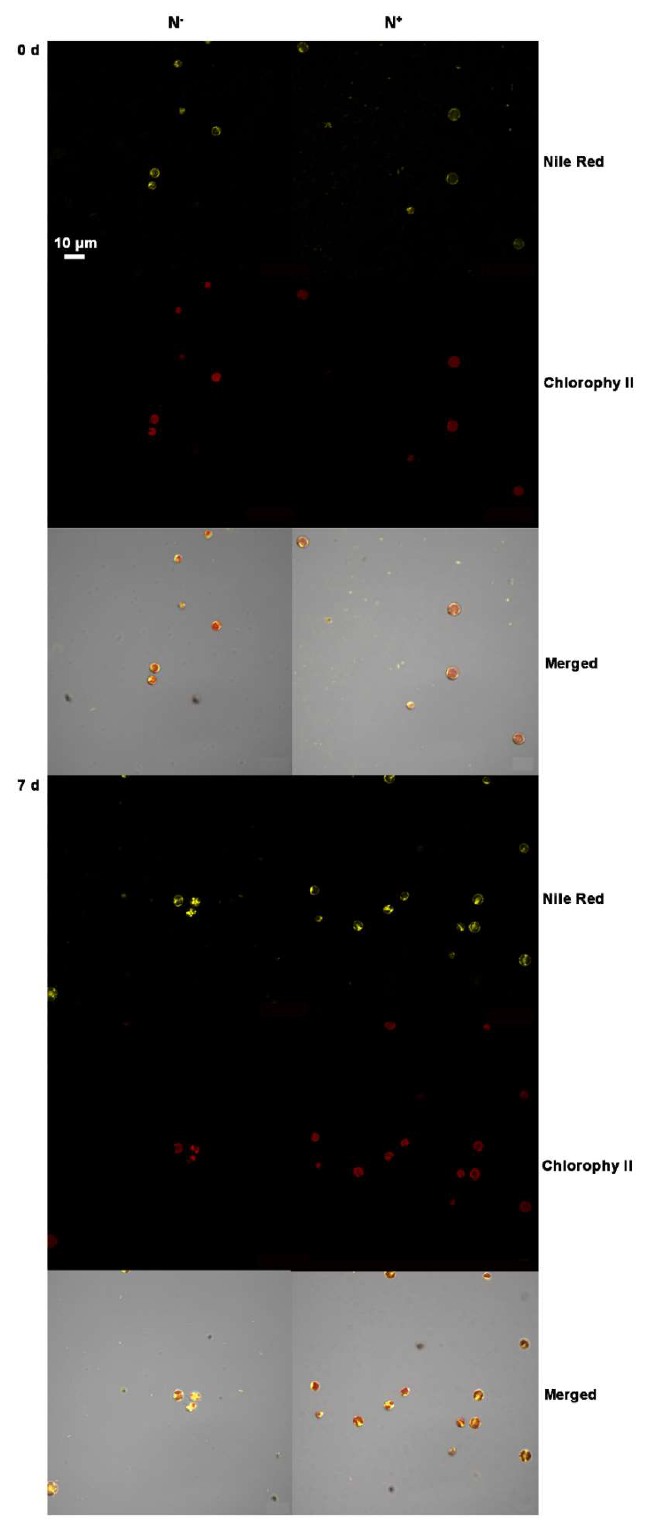
Figure 6. Representative confocal laser scanning micrographs of Parachlorella kessleri TY02 cells labeled with Nile Red. CLSM (confocal laser scanning microscopy) images of cells with NR fluorescence (yellow) and Chl autofluorescence (red) were recorded on the 0 day and 7th day under N − and N + culture media. All figures are representative of three replicated studies with similar findings. Scale bar: 10 µ